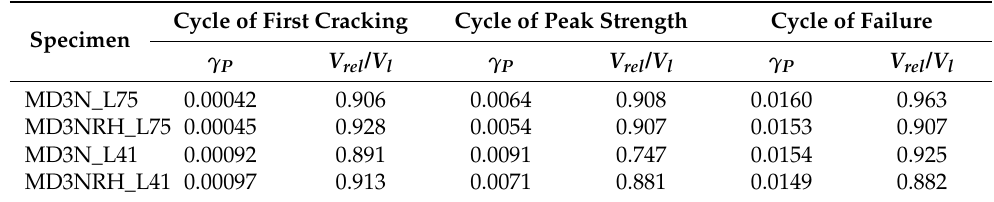
Table 3. Residual drift after unloading and reloading/loading ratio.